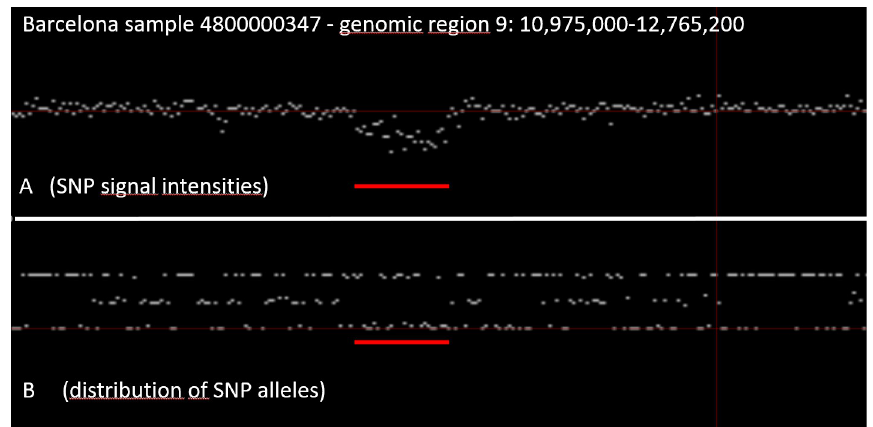
Fig 4. Detail of Fig 3 (arrow) region demonstrating a deletion in one of the two chromosomes.